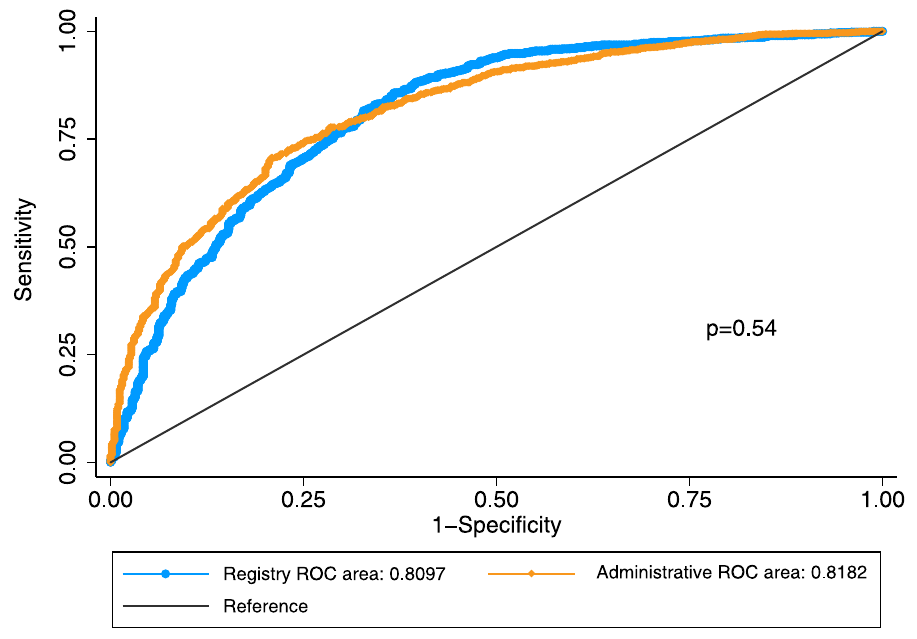
Fig 1. Comparison of ROC curves between registry and administrative